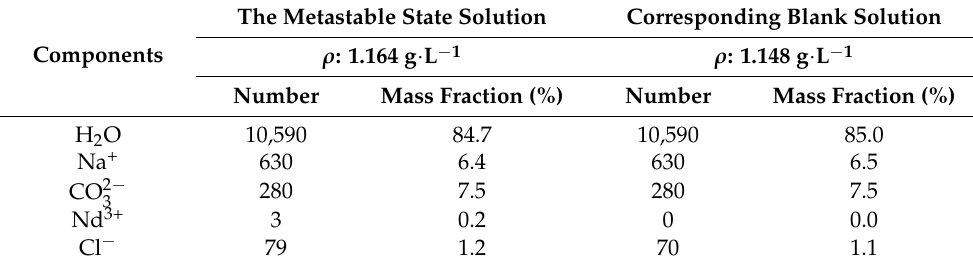
Table 3. Modeling parameters of the